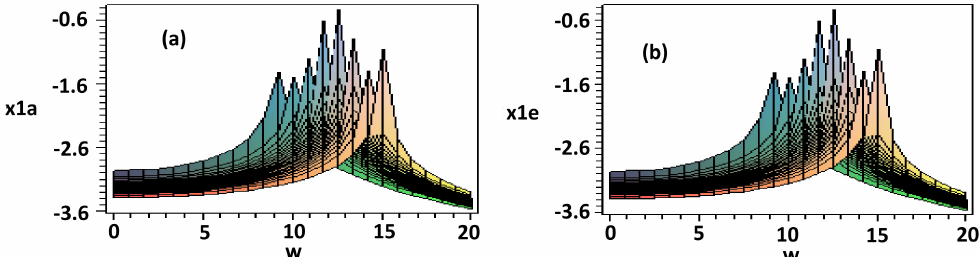
Figure 10. Evolution of x 1 (w) as a function of P 1 : ( a ): Present approach. ( b ): Exact